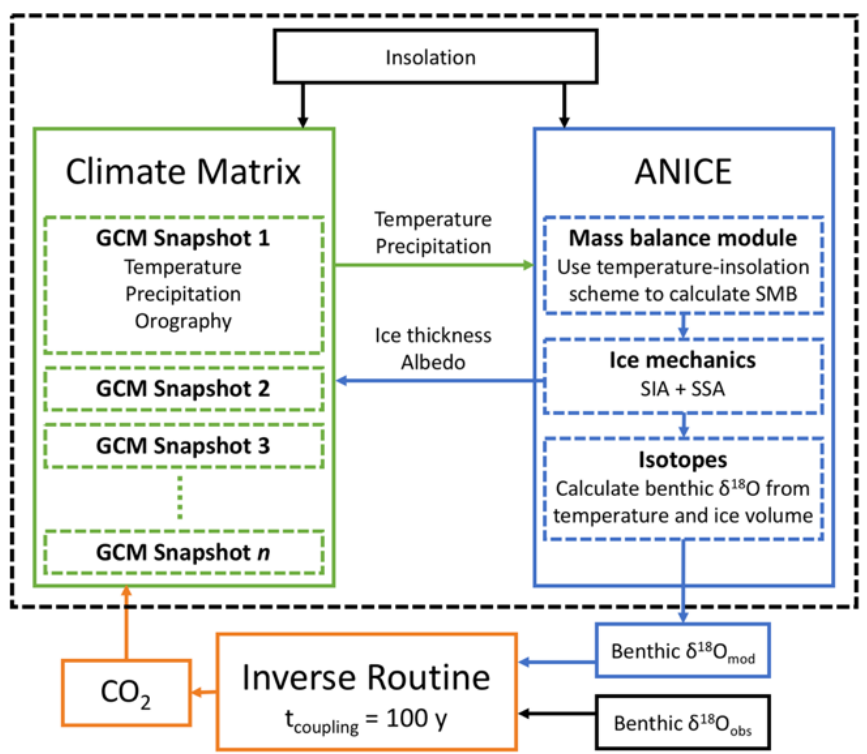
Figure 2. A conceptual visualization of the inverse forward modelling approach. The model is forced externally by an insolation reconstruc- tion and a benthic δ 18 O record (black boxes). p CO 2 is changed over time based on the difference between observed and modelled δ 18 O. The climate matrix interpolates between the pre-calculated GCM snapshots, based on the prescribed p CO 2 value and the modelled state of the cryosphere (ice thickness and albedo), to determine the climate that is used to calculate the surface mass balance over the ice sheets. The modelled ice sheets and climate are then used to calculate a modelled benthic δ 18 O value, which is used to update modelled CO 2 in the next time step. Figure adapted from Berends et al.